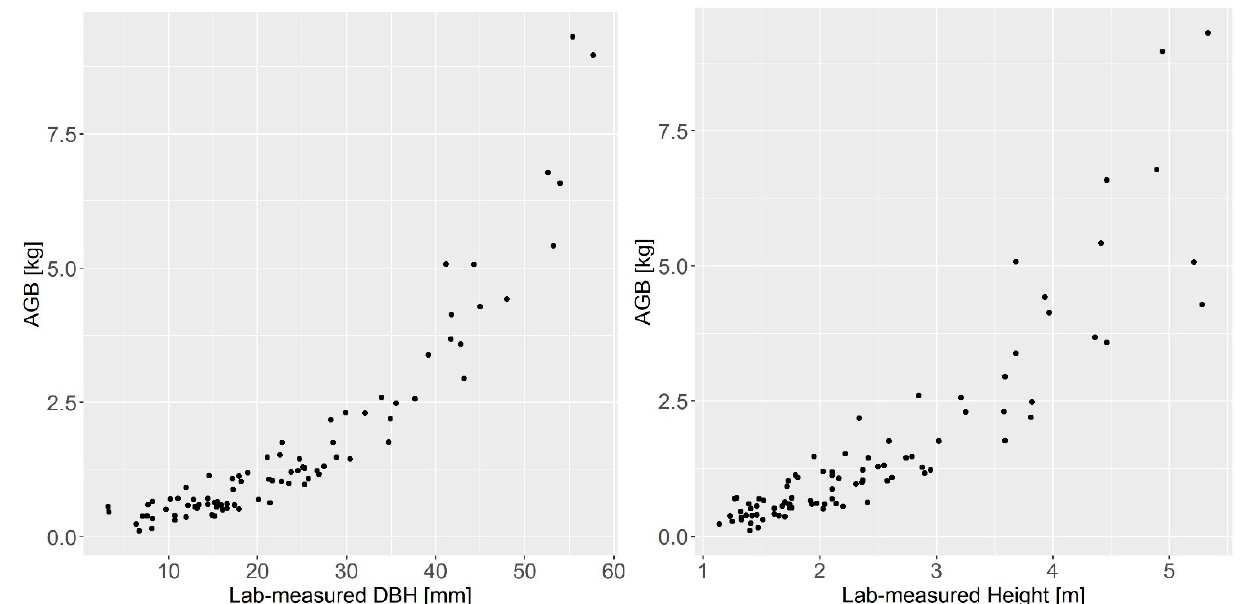
Figure 2. Scatterplots showing lab-measured diameter at breast height (DBH) versus above ground biomass (AGB) ( left ) and lab-measured height versus AGB ( right ) for the 89 trees used in this study.